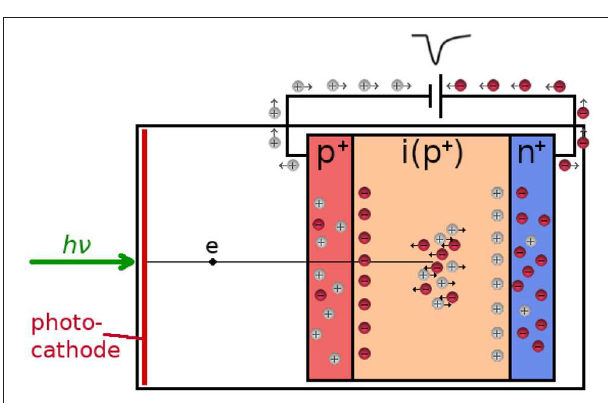
FIGURE 7 | In a hybrid detector, the photoelectron from the photocathode is accelerated through a high voltage into the p-n junction, where it creates a large number of electron-hole pairs. The gain is further increased by impact ionization, producing a timing pulse at the